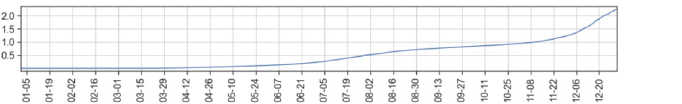
Fig 2. Total daily cases. This total indicates positive test results summed over the entire state from county-level reports each day.